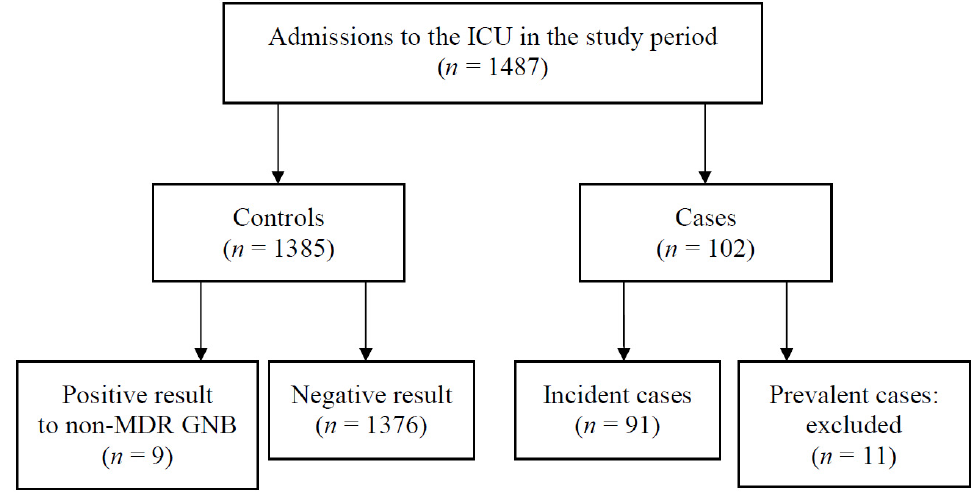
Figure 1. Distribution of the study participants.